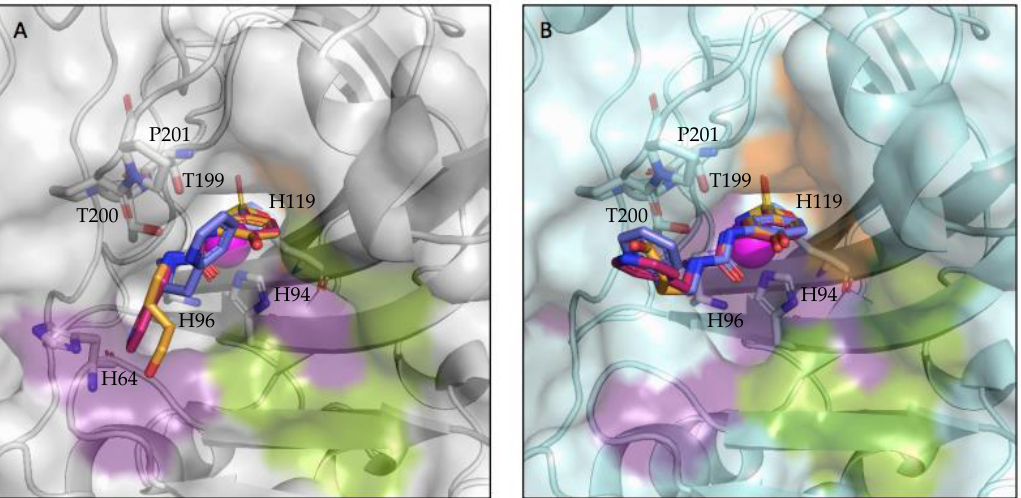
Figure 2. Compounds bound to the active site of ( A ) CA II (grey) and ( B ) CA IX-mimic (cyan) with the hydrophobic (orange), hydrophilic (purple), and selective (green) pockets shown. Zinc depicted as a magenta sphere, compound 3g is shown in pink, compound 3h is shown in purple, and compound 3j is shown in orange; the three compounds have been overlayed. Compounds 3g and 3h have highly similar structures, similar binding patterns to CA IX-mimic, and similar affinity for CA IX over CA II. Compound 3g contains a 2-ureido- benzenesulfonamide and 3h contains a 1-ureido-benzenesulfonamide, relative to the het- erocyclic pyridyl functional group. The pyridyl group is at a 107° angle (-NH-CH2-Py) in 3g and a 114° (-NH-CH2-CH2) angle for 3h , highlighting the similarity between the two high affinity complexes that exemplify a textbook case of isozyme-specific selectivity. Both 3g and 3h have a hydrophobic interaction with F131 in complex with CA II, and this bulky residue introduces energetically disfavored steric hindrance in its interaction with the para -hydroxide of the benzenesulfonamide zinc-binding group. This hydroxide is rig- idly set in its position, roughly 3.0 Å away from F131, as a result of the tight <2 Å bond formed between the sulfonamide and zinc and the planarity of the benzenesulfonamide. This disfavored polar-hydrophobic interaction is somewhat mitigated in the complex formed between 3g and CA II, by way of a hydrogen bond formed between H64 and the pyridine ring. The substitution of the pyridine and slightly elongated (one more carbon) chain of 3h are most likely responsible for the absence of this interaction (Figure 3).